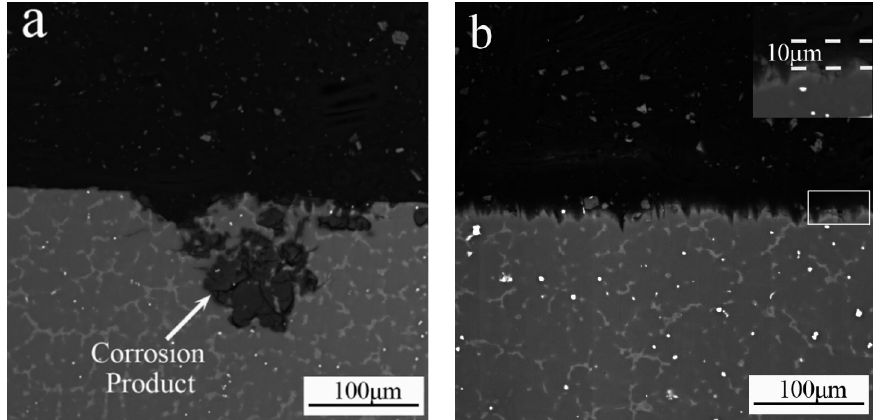
Figure 11. Back-scattered electron imaging of a corrosion longitudinal section of the ultrasonic-treated ( a ) AZ91 alloy and ( b ) AZ91–1.5Sm alloy after immersion in aqueous 3.5 wt % NaCl solution for 1 h.